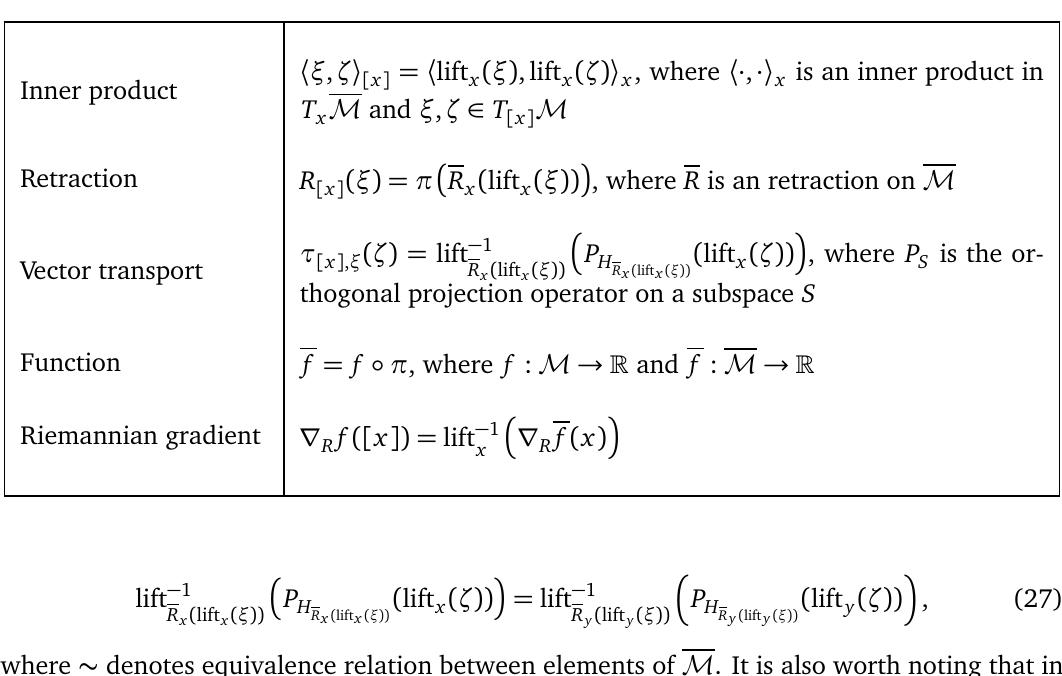
expressed through optimization primitives of M